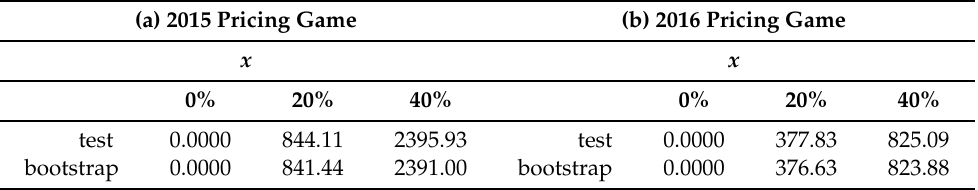
Table 1. The values for ν such that x % of the absolute differences between the observed values is smaller than ν . This is done for the original test set and the bootstrap version, for the datasets of both the 2015 and 2016 pricing